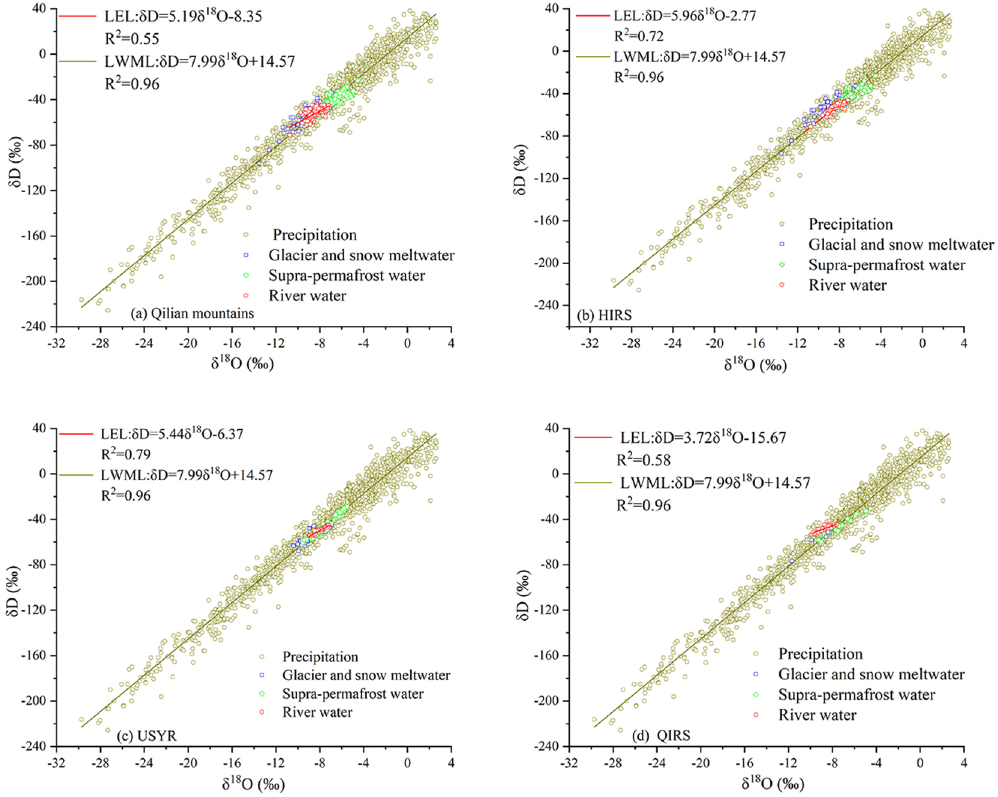
Figure 8. Relationships of δ 18 O and δ D between river water and various water types in (a) the Qilian mountains, (b) HIRS, (c) USYR, and (d)